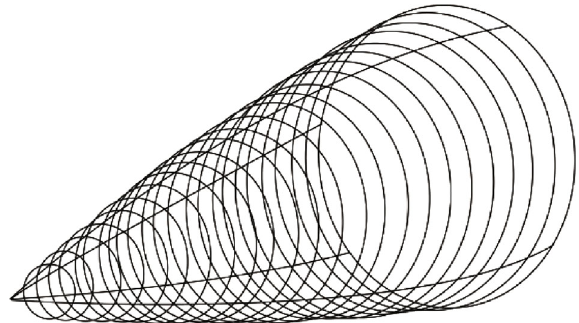
Figure 1: Schematic illustration of noncircular missile